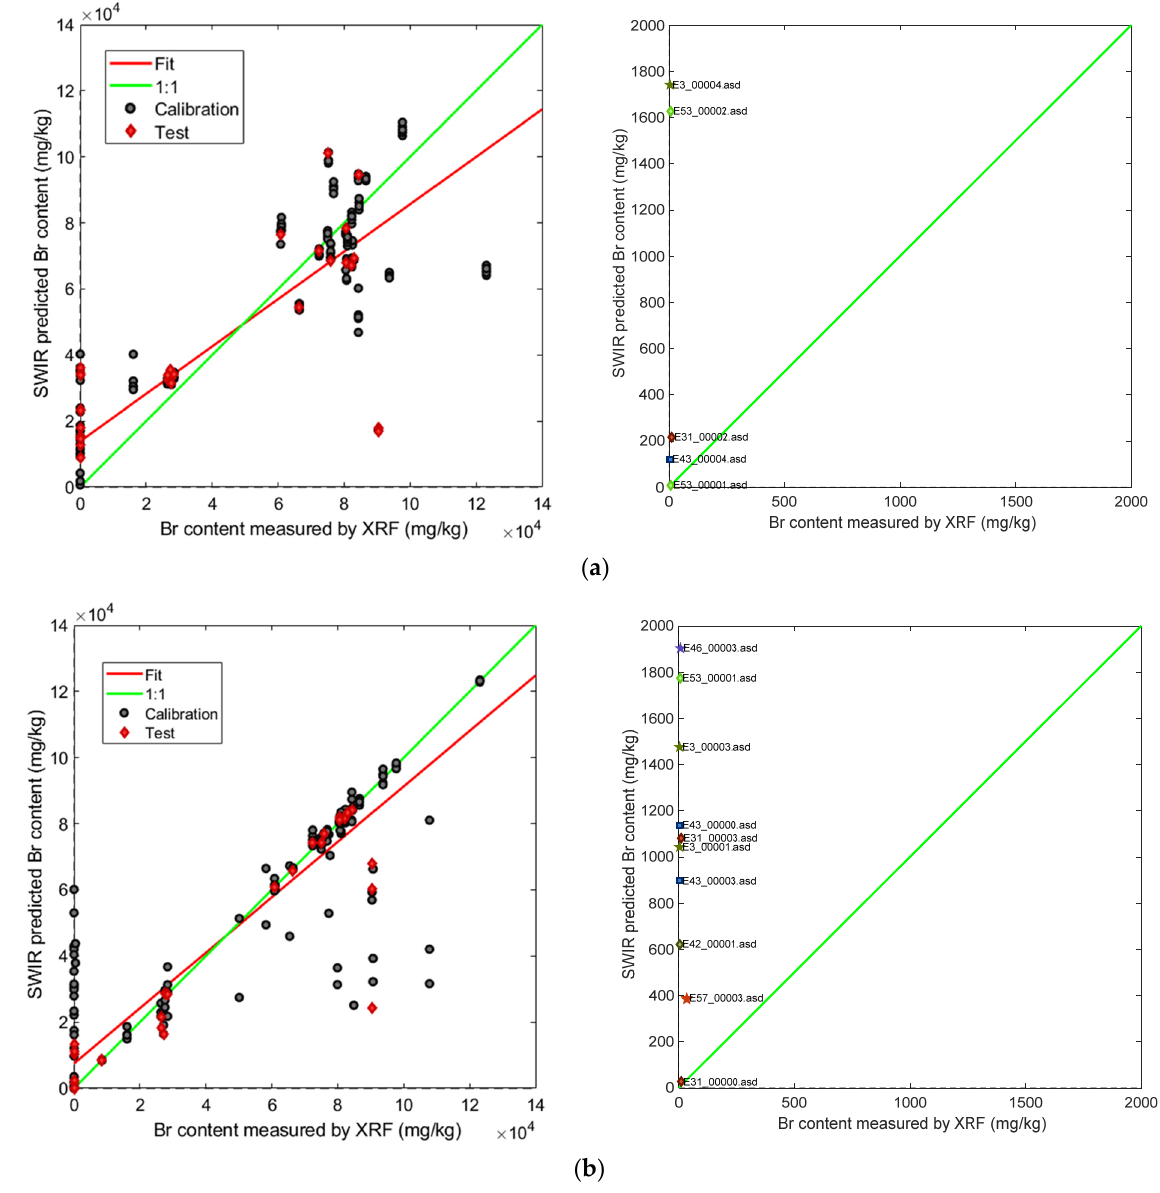
Figure 5. The partial least squares regression (PLSR) ( a ) and the locally weighted partial least squared regression (LWPLSR) ( b ) for bromine content from SWIR reflectance spectra. Plots on the left represents the results in prediction of the regression models in the range of Br content from 0 to 14 × 10 4 mg/kg. Plots on the right are a graphical representation of the calibrated regression scores in the range of Br content from 0 to 2000 mg/kg, the latter value corresponds to the Br concentration limit defined in the technical specification CENELEC CLC/TS 50625-3-1 [11]. Table 1. The partial least squares regression (PLSR) and the locally weighted partial least squared regression (LWPLSR) results for bromine content from SWIR reflectance spectra.